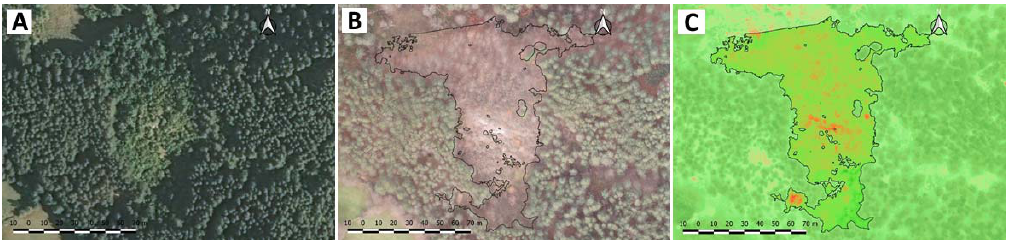
Figure 3. GIS application for determination of the boundaries of bark beetle spots in Kremen region: ( A ) aerial 2011 RGB image; ( B ) UAV 2019 RGB image; ( C ) UAV 2019 NDVI image.